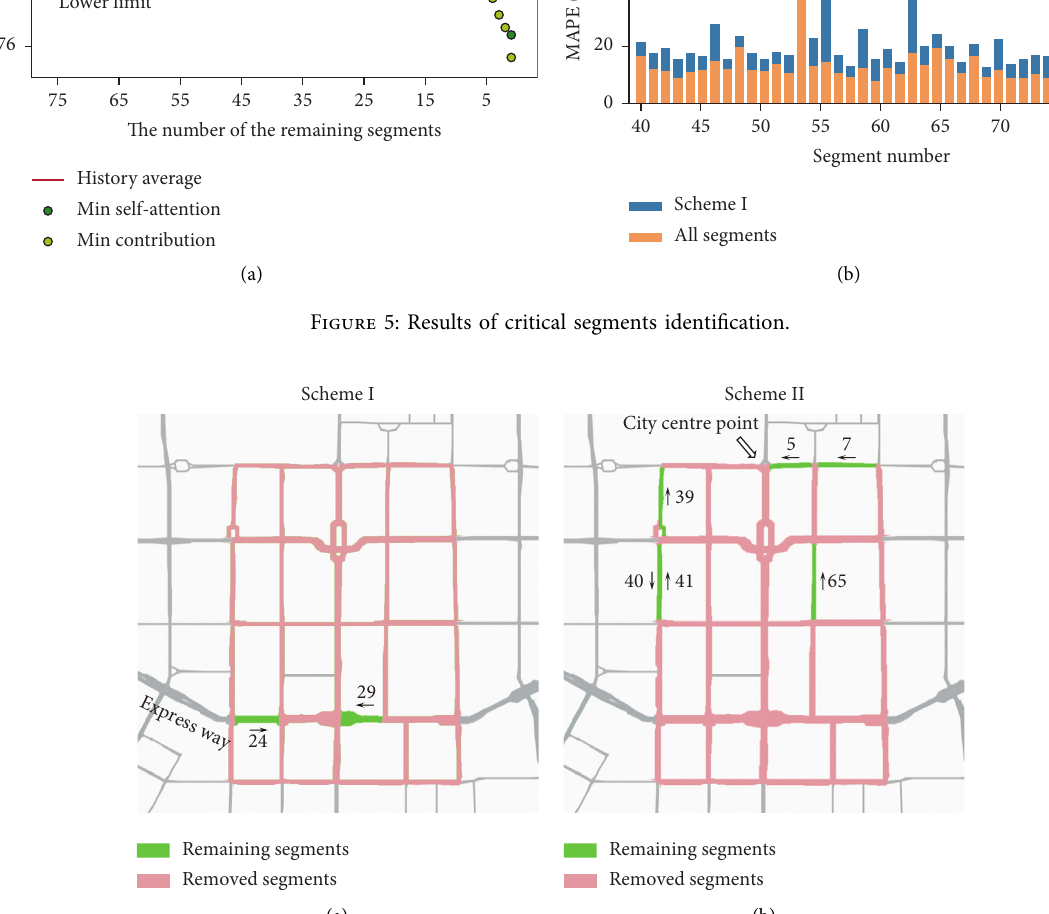
Figure 6: Geographic visualization of critical segments identification schemes.